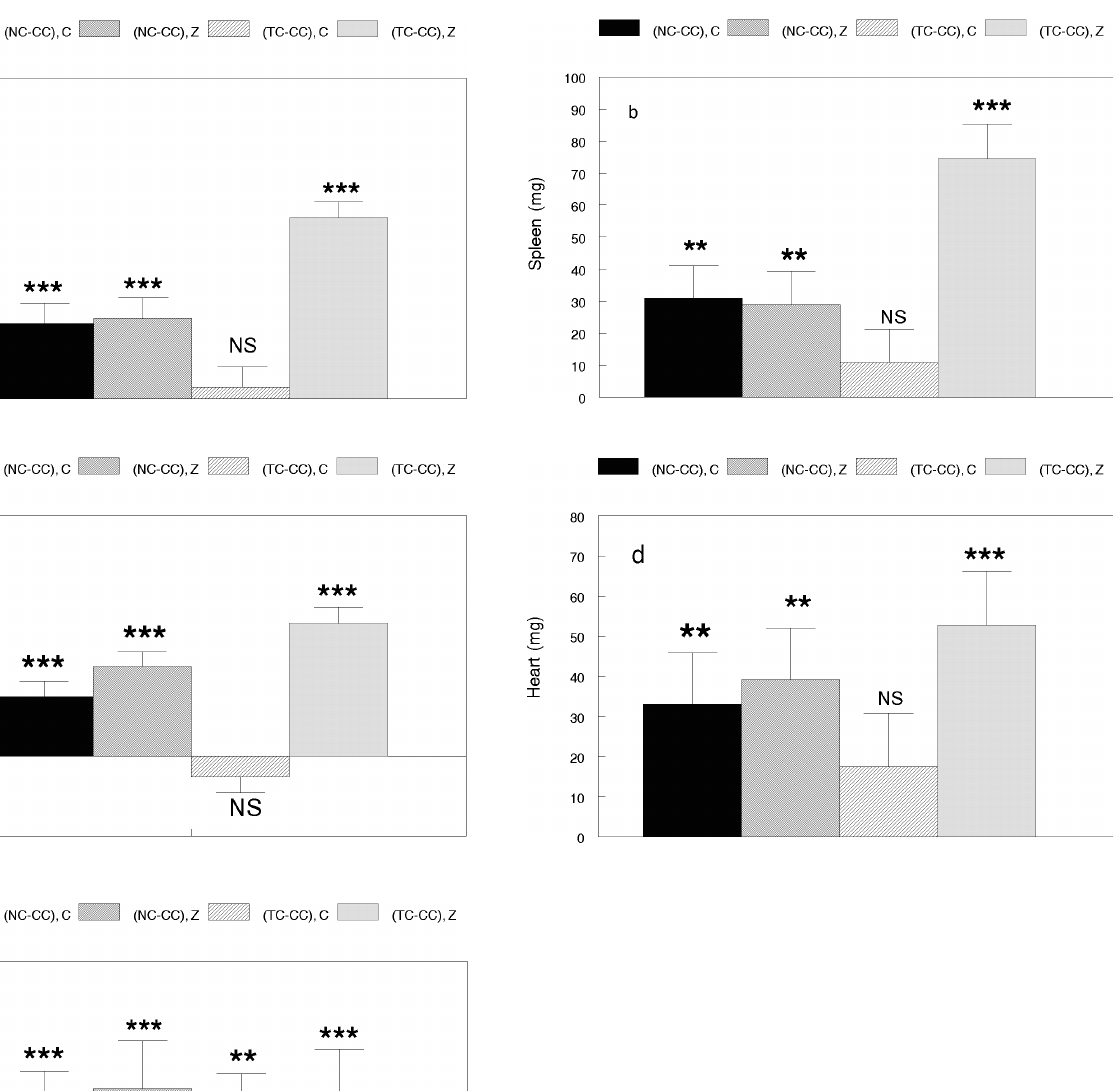
Figure 1 - Correlated responses for absolute organ weights (mg) in the NC and TC lines with (Z) and without (C) zinc supplementation expressed as deviations from the means of CC, the randomly selected control line: a ) liver, b ) spleen, c ) kidney, d ) heart, e ) testis. NC and TC are nontransgenic and transgene-carrier lines, respectively, originating from the same back- ground as CC, and subsequently selected for 8-week body weight. NS = Not significant, **P < 0.01, ***P <